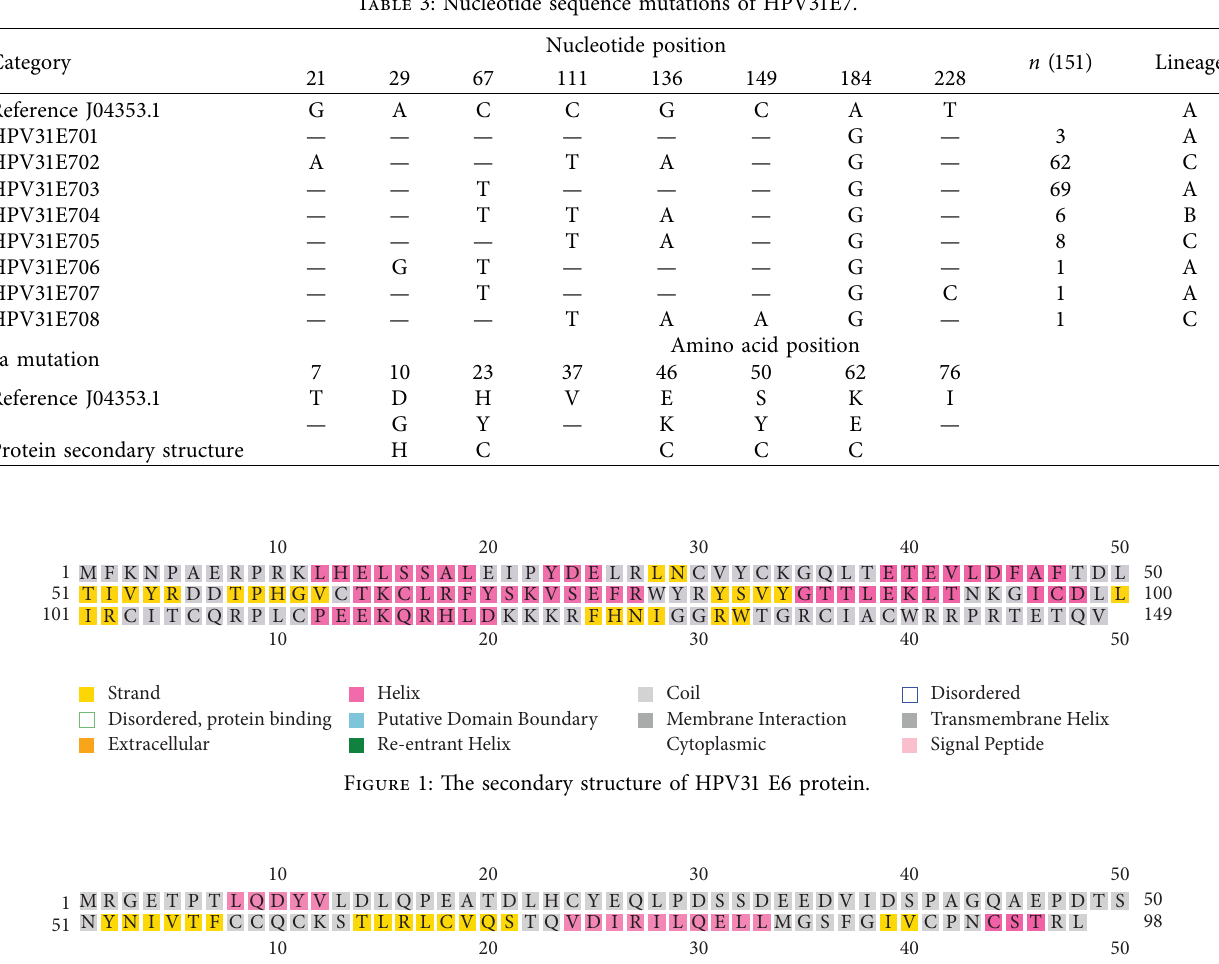
Table 3: Nucleotide sequence mutations of HPV31E7.